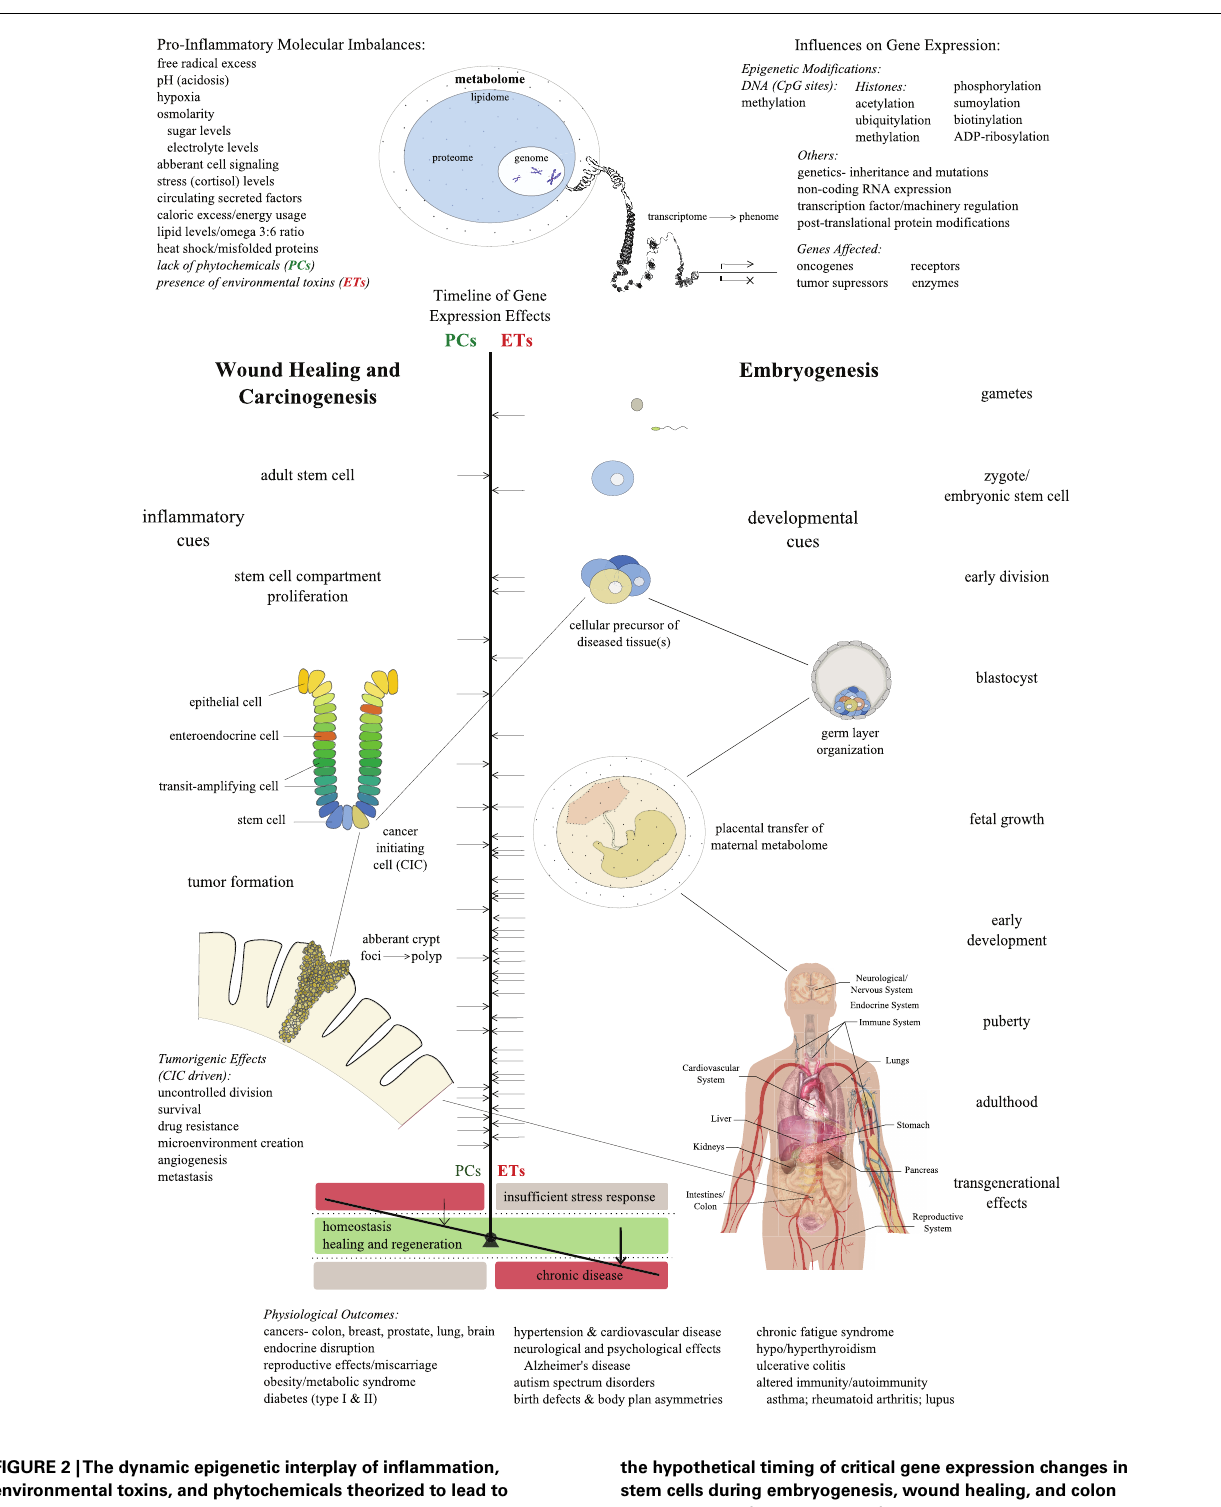
the hypothetical timing of critical gene expression changes in stem cells during embryogenesis, wound healing, and colon carcinogenesis (in this scenario), with other outcomes